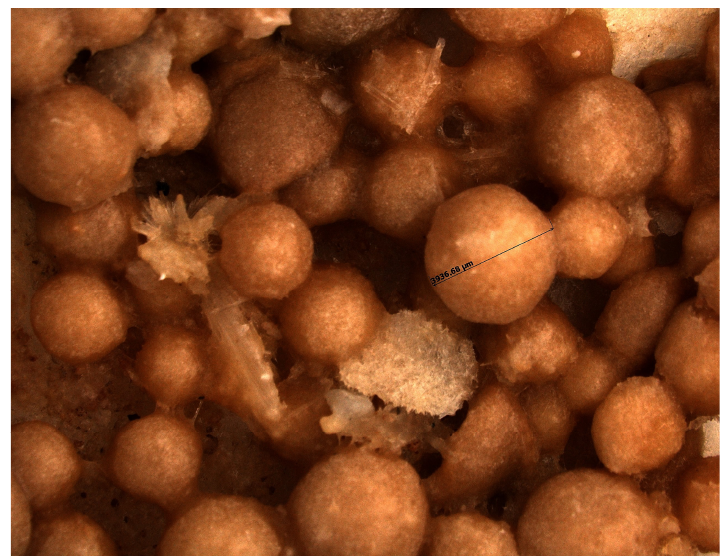
Figure 4. R. delemar pellets at the end of the plaster sand run. The pellets were collected from the